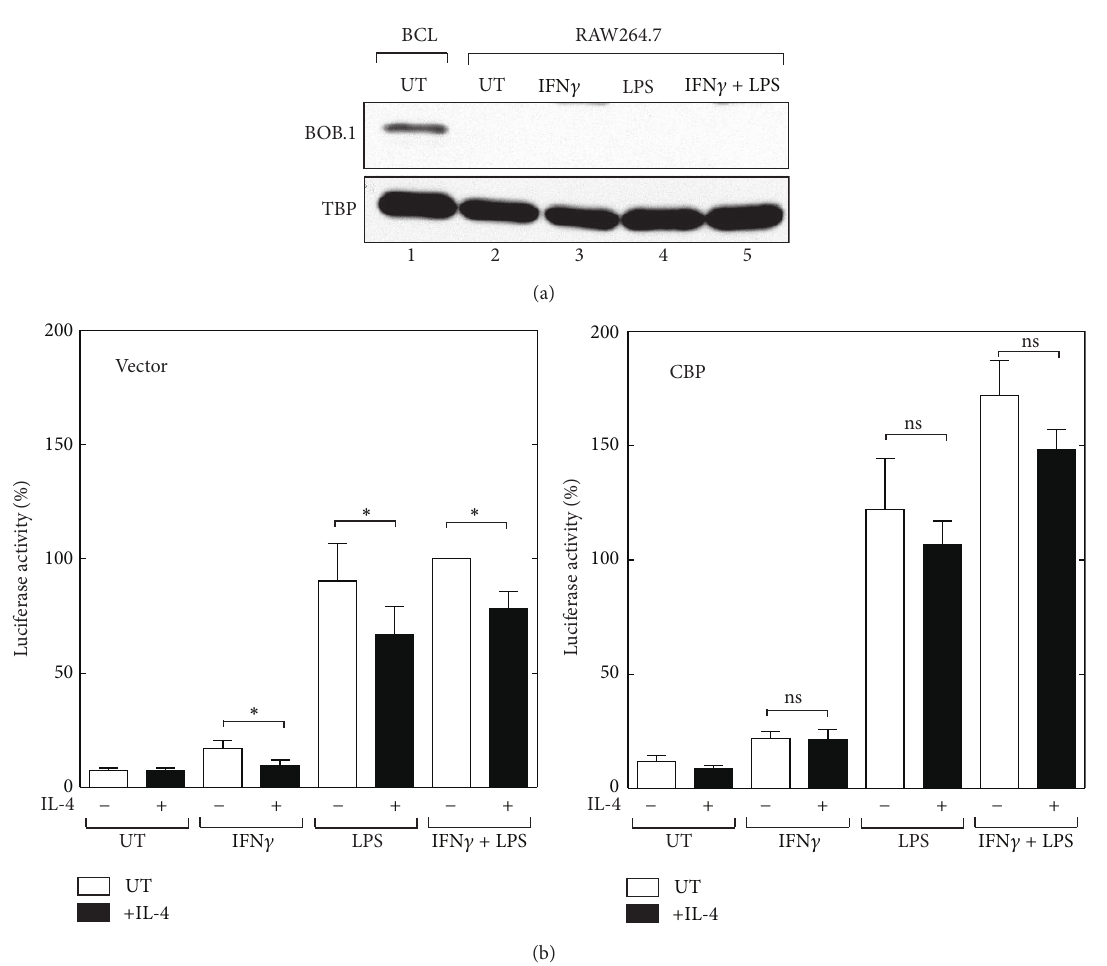
Figure 7: Overexpression of the coactivator CBP partially attenuates the IL-4-mediated inhibition of Nos2 promoter activity in RAW264.7 cells. (a) Analysis of endogenous BOB.1 expression in RAW264.7 cells. The cells were treated with medium alone (UT) or IFN 𝛾 (10ng/mL) and/or LPS (100ng/mL) for 8 hours before the preparation of nuclear extracts. Twenty micrograms of nuclear extract was analyzed by western blotting using an antibody against BOB.1 or an antibody against TATA-binding protein (TBP), which was used as a loading control. Nuclear extracts from the mouse leukemia cell line BCL1-B20 (BCL) were used as a positive control for BOB.1 expression (lane 1). (b) RAW264.7 cells were transiently co-transfected with either the empty vector or wild-type CBP expression plasmid and the pNOS-62 luciferase reporter construct. Twenty-four hours after transfection, the cells were treated with medium alone (untreated: UT) or IL-4 (10ng/mL) for 30min prior to stimulation with IFN 𝛾 (10ng/mL) and/or LPS (100ng/mL) for 8 hours before the measurement of luciferase activity. The relative luciferase activities are shown as the percentage of the activity of cells transfected with the empty vector and stimulated with IFN 𝛾 and LPS. Each column and bar represents the mean ± SEM of three independent experiments. The asterisks denote a statistically significant difference compared to the cultures treated with IL-4 ( 𝑃 < 0.05 , Student’s 𝑡 test; ns, not